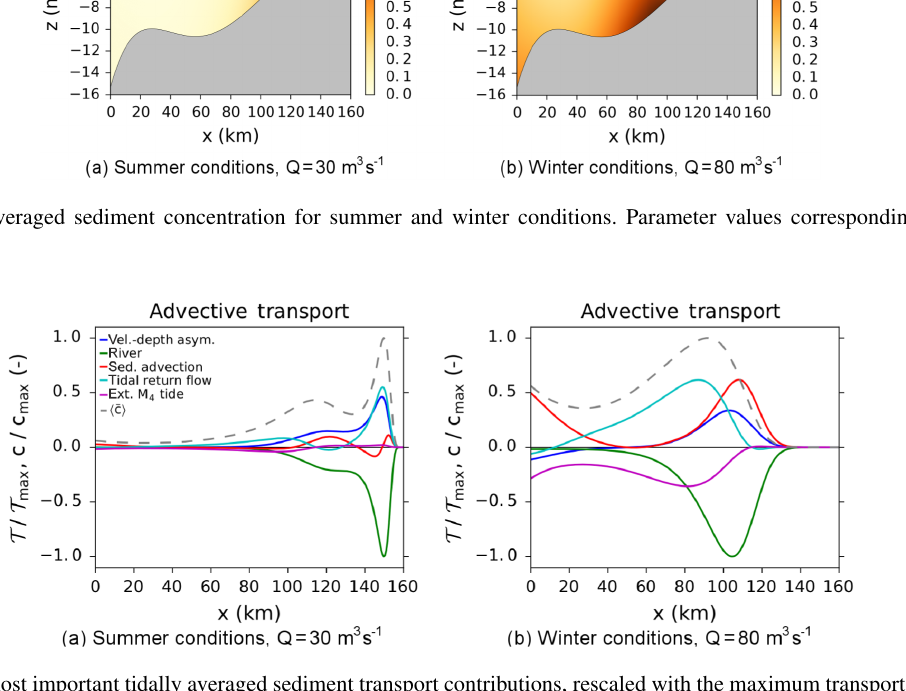
Figure 12. The five most important tidally averaged sediment transport contributions, rescaled with the maximum transport. Negative values indicate export, while positive values indicate import. Total net transport of all terms added yields zero. The scaled tidally averaged depth- averaged sediment concentration (grey dashed line) is plotted in the background for reference. Parameter values corresponding to the Scheldt